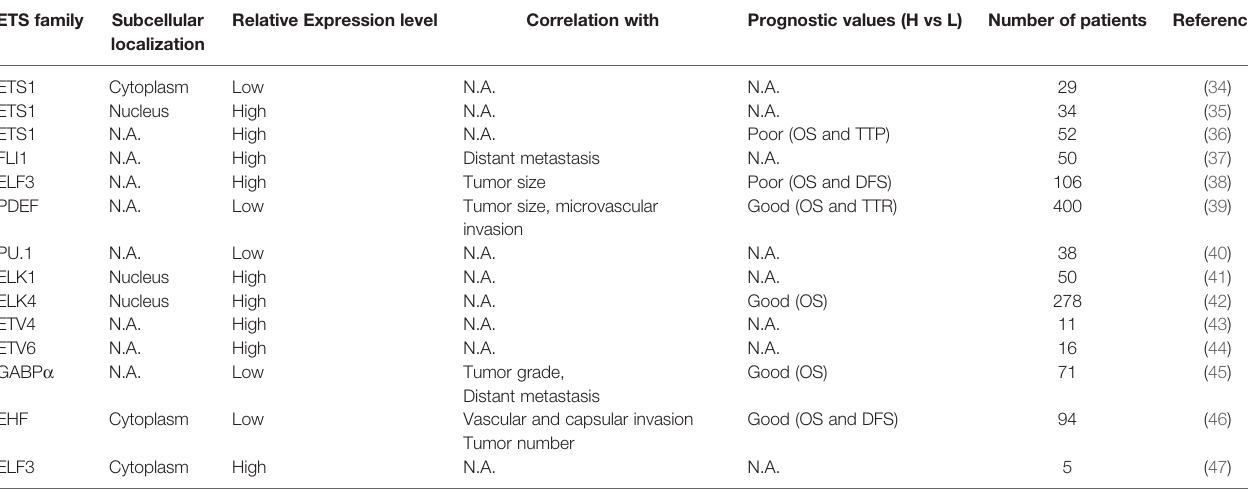
TABLE 1 | The expression of the ETS transcription factors in HCC and their association with clinical-pathological features and patients ’ survival. ETS